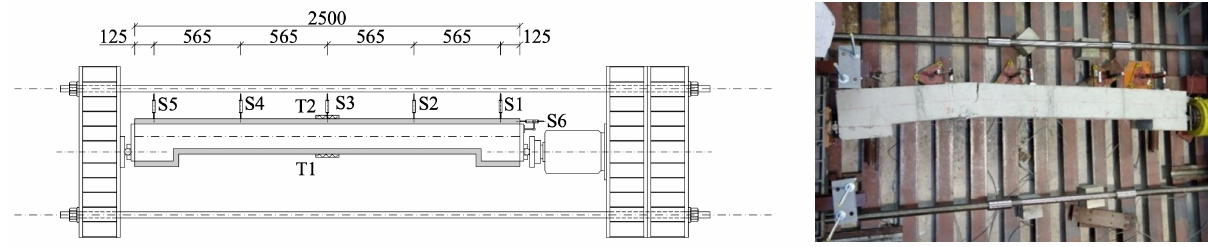
Figure 1. Experimental program, a) load of a sample, b) sample after loading.